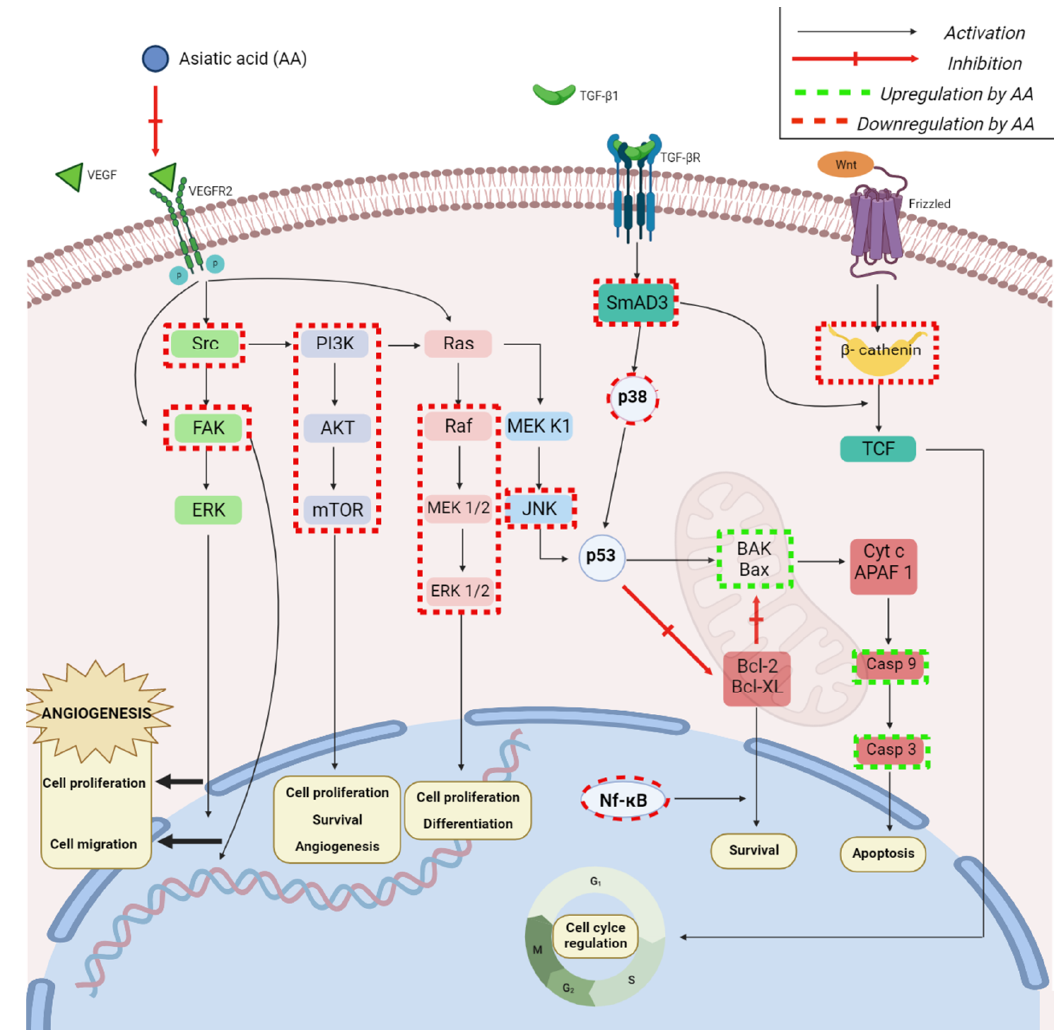
Figure 5. Schematic representation of the reported anticancer mechanisms of AA; key signaling pathways targeted by AA in cancer: Src/FAK/ERK signaling pathway inhibition -> inhibition of angiogenesis, cell proliferation, and migration; PI3K/Akt signaling pathway inhibition -> inhibition of angiogenesis, cell survival, and proliferation; inhibition of MEK/ERK pathway -> inhibits cell proliferation and differentiation; inhibition of TGF-β1/Smad3 signaling pathway -> inhibition of cell survival; inhibition of Wnt/β-catenin signaling pathway -> inhibition of cell proliferation and migration. Created with BioRender.com (accessed on 8 May 2022).